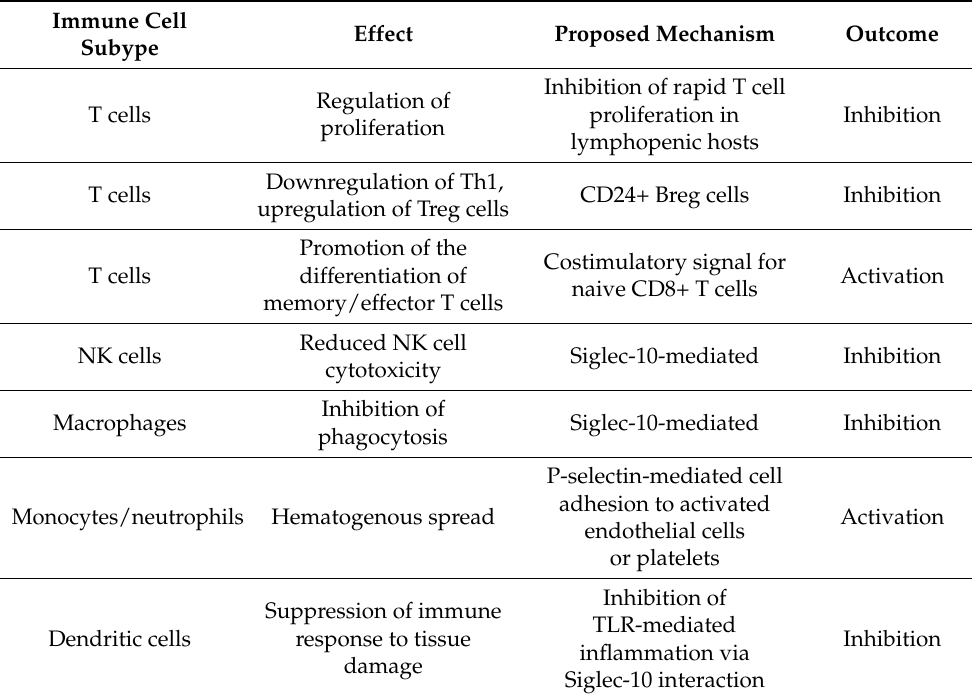
Table 2. Effects of CD24 signaling different subtypes of immune